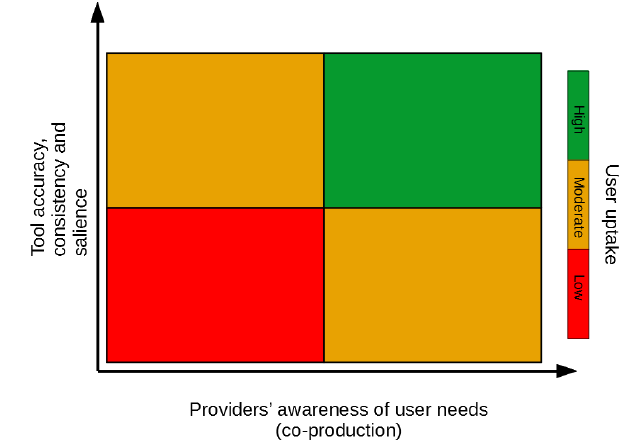
Figure 6. A conceptual matrix illustrating user uptake as a function of co-production and tool accuracy and consistency. This frame- work illustrates the co-dependence between science communication and bespoke, user centric, forecasting tools and